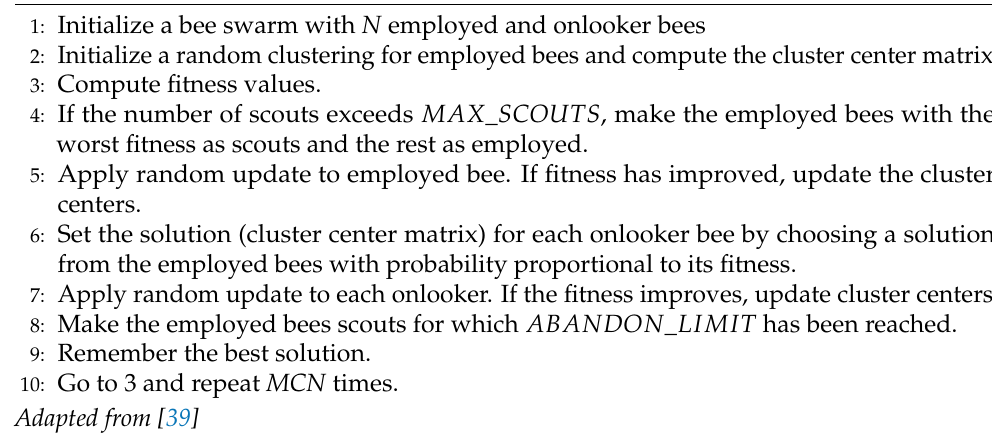
Algorithm 2 Artificial Bee